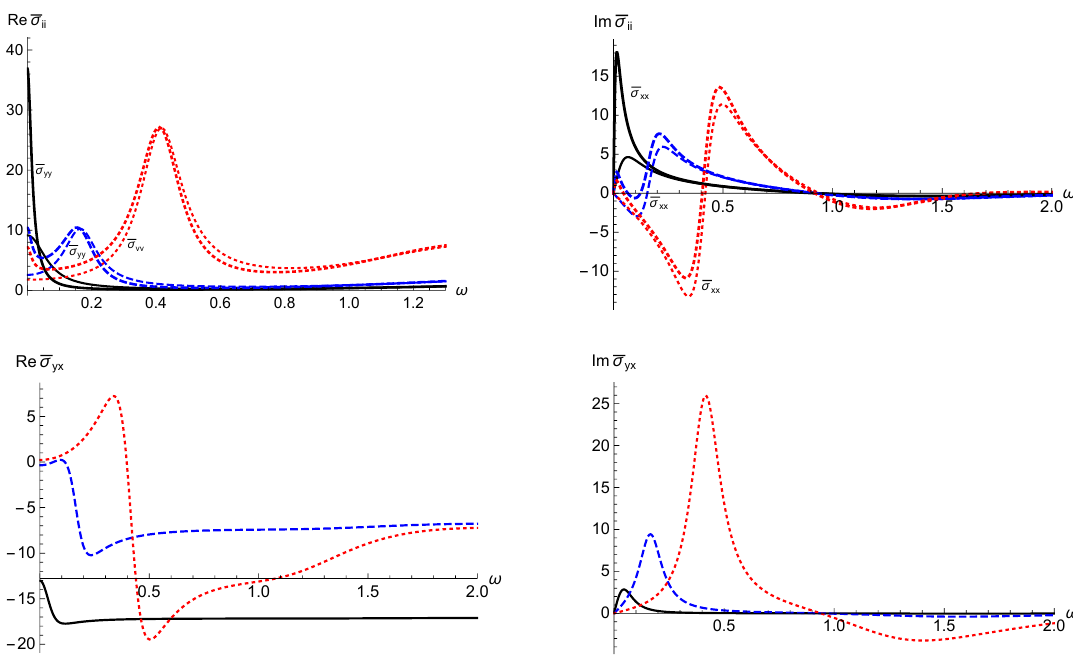
Figure 4 . (cid:22) (cid:21) 1 ( z ) and (cid:22) (cid:21) 2 ( z ) for di(cid:11)erent values of (cid:22) Q m = 0 : 1 (black-solid) , (red-dotted) where we take k 1 = 0 : 1, k 2 = 0 : 4, and (cid:22) Q e = 0 : 1.